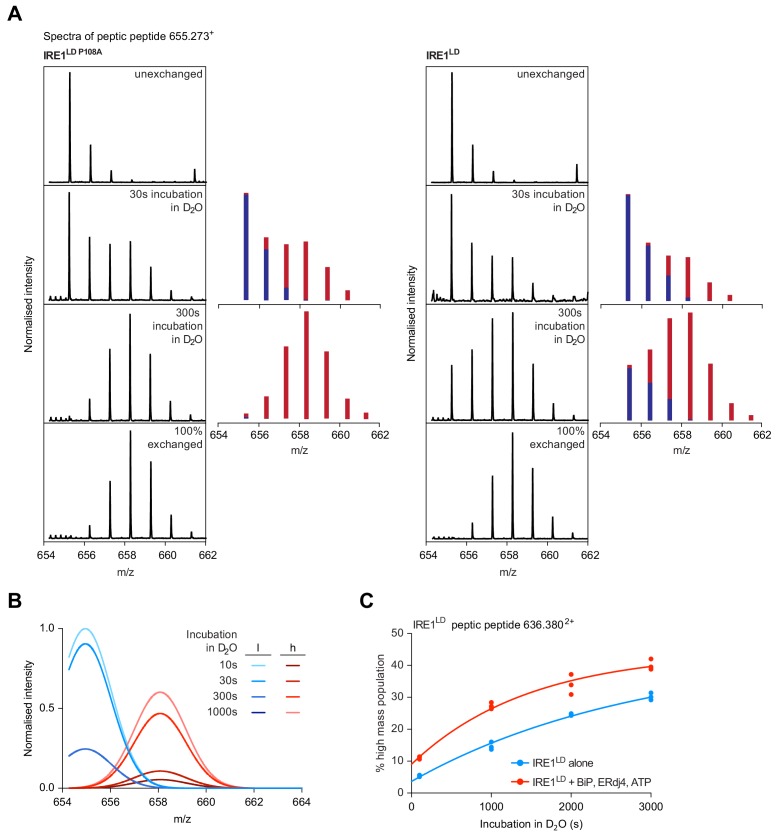
Analysis of the bimodal distributions of the isotope clusters detected by HX-MS.(A) Shown are original spectra of peptic peptide 655.273+ (residues 297–302) from monomeric IRE1LD P108A (left panel) or wild-type IRE1LD (right panel) at the indicated time point of incubation in D2O. The contribution of the low (blue) and high (red) exchanging populations to the peaks was extracted by fitting the data to a two Gaussian distribution model (Equation 4). Unexchanged and 100% exchanged spectra are provided as references. (B) Plot of the two individual Gaussian distributions of the high (h) and low (l) exchanging populations deconvoluted computationally in Prism GraphPad 7.0 from the composite data set shown in Figure 7A for each time point of incubation in D2O. (C) Plot of time-dependent change in the fractional contribution of high mass species to the isotope clusters of peptic peptide 636.3802+ (residues 96–106). Shown are data points from three independent samples of IRE1LD in presence and absence of BiP, ERdj4 and ATP (as in Figure 7B). The curves were fitted to a one-phase association model in Prism GraphPad 7.0.